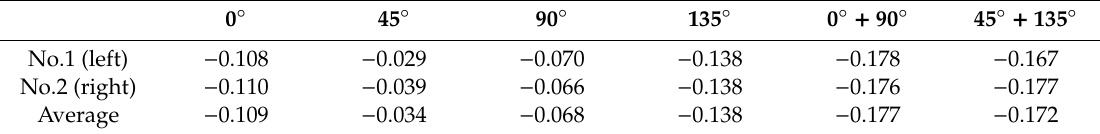
Table 2. Diametral displacements at di ff erent angles for the first borehole (Unit: mm). 0 ◦